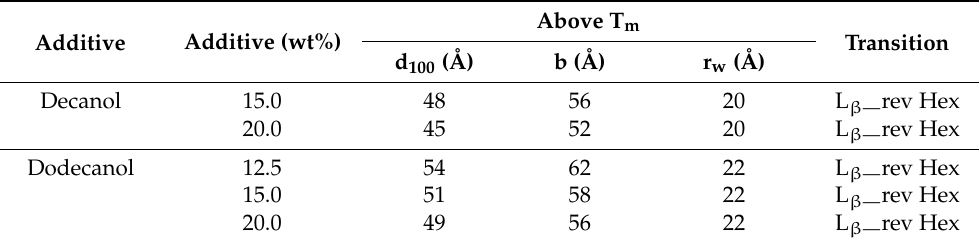
Table 7. Unit cell values calculated from the X-ray scattering patterns of DODAC in the presence of decanol and dodecanol at 65 o C for a reversed hexagonal phase. r w is the polar domain radius. Above T m Transition Additive Additive (wt%) d 100 (Å) b (Å) r w